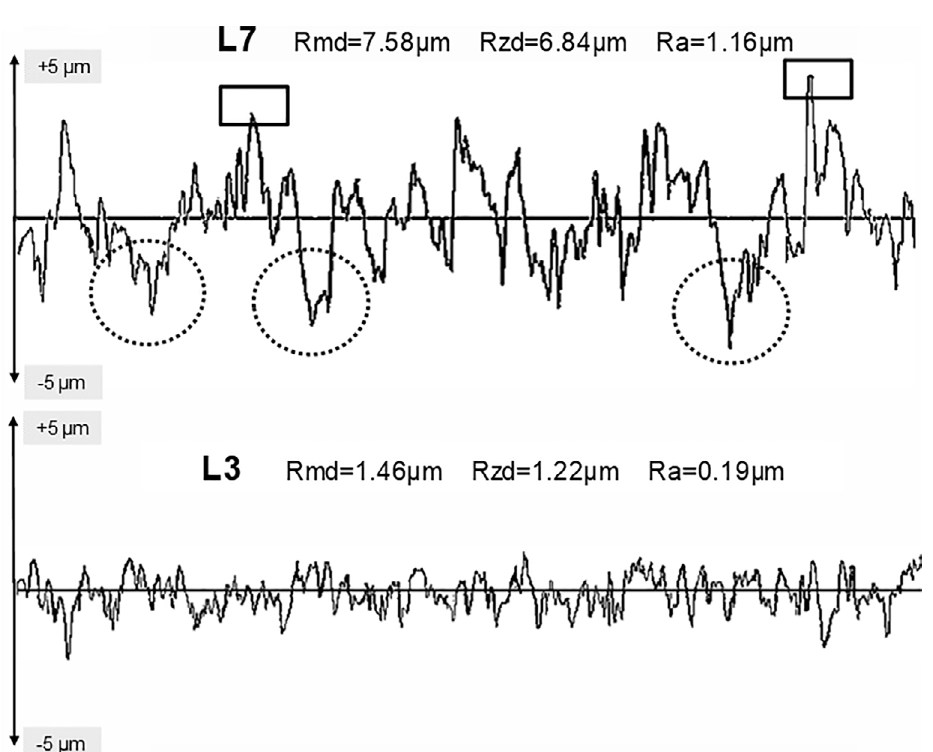
Figure 9. Roughness profiles of L7 and L3